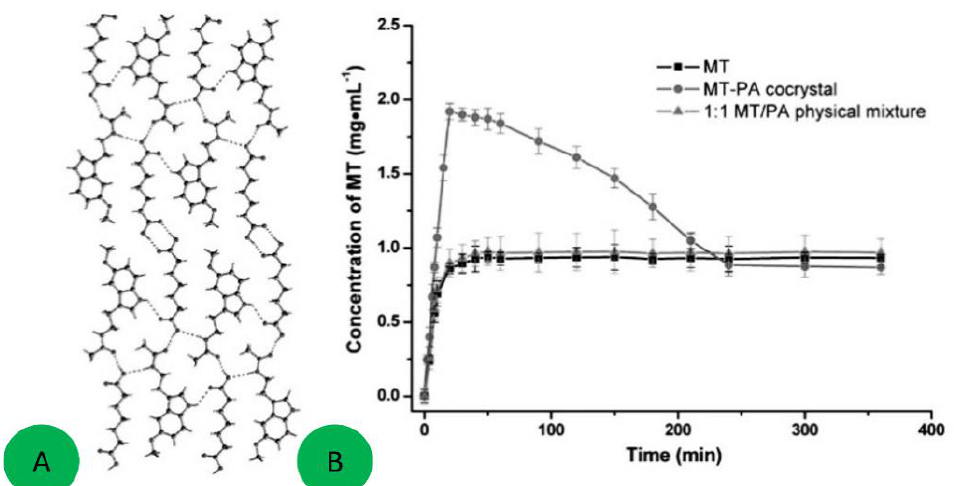
Figure 25. Packing diagram of the melatonine/pimelic acid co-crystal showing the hydrogen bonding ( A ). Powder dissolution profiles of melatonine, melatonine-pimelic acid co-crystal, and of a 1:1 physical mixture in PBS (pH 6.8) at 37 °C ( B ). Adapted with permission from Ref. [87]. 2015, Royal Society of Chemistry.